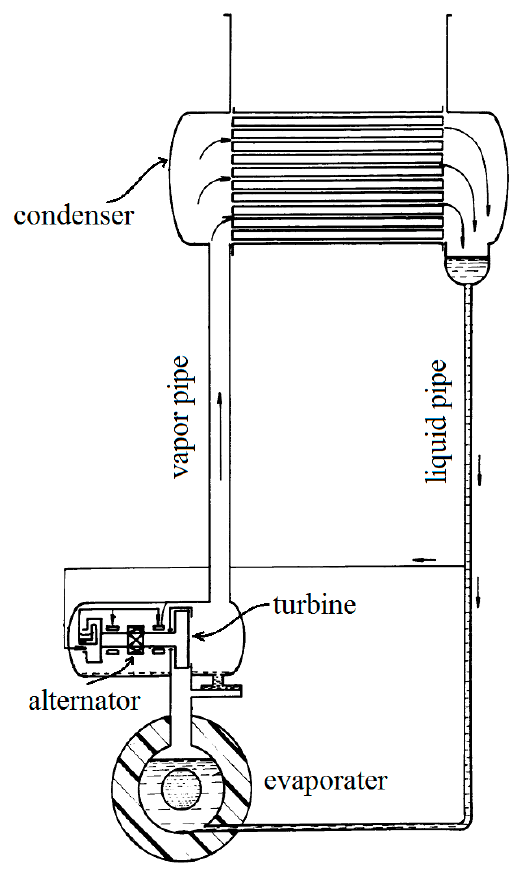
Figure 1. A novel apparatus in a French patent.